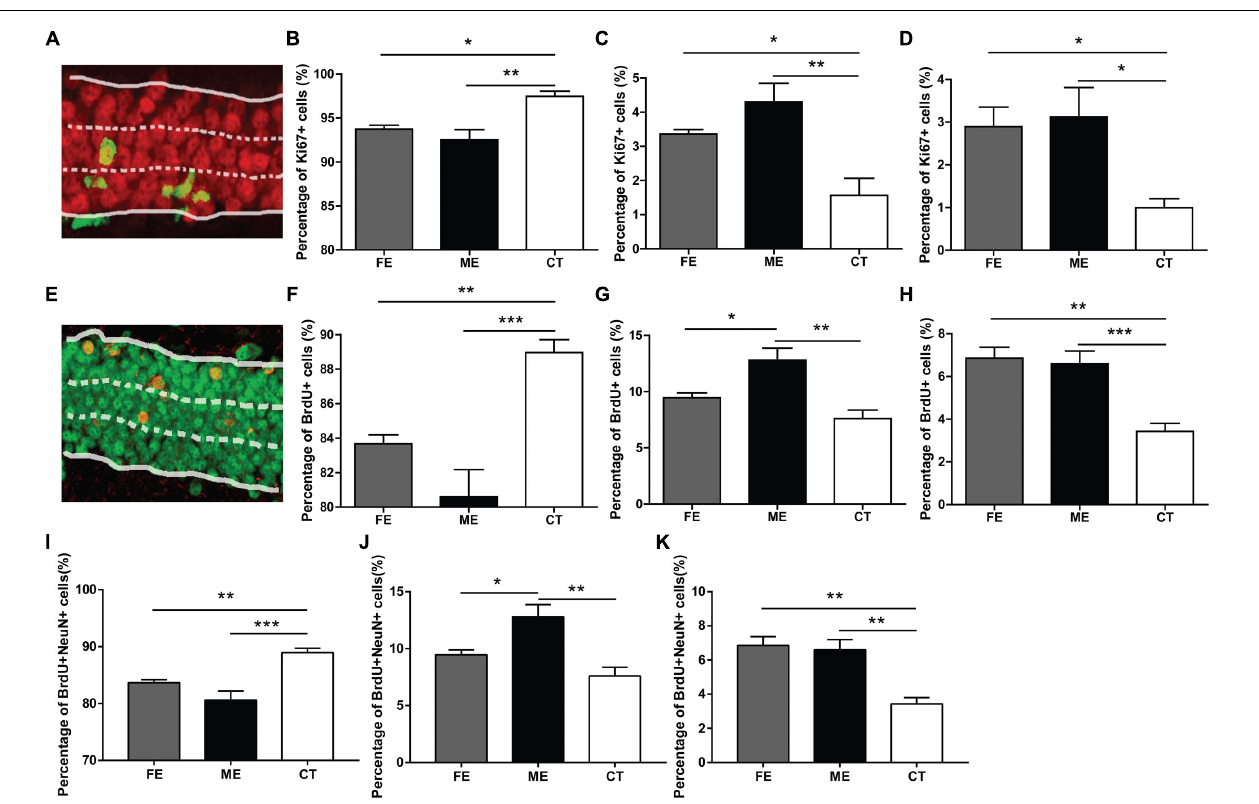
FIGURE 3 | Distribution of new neurons in the granule cell layer (GCL) of runners. (A) A sample photomicrograph of Ki67 + cells in the GCL. (B) Both FE and ME groups have a lower percentage of Ki67 + cells located in the innermost GCL than the CT group. One-way ANOVA, F 2 , 12 = 5.594, P = 0.0192; post hoc